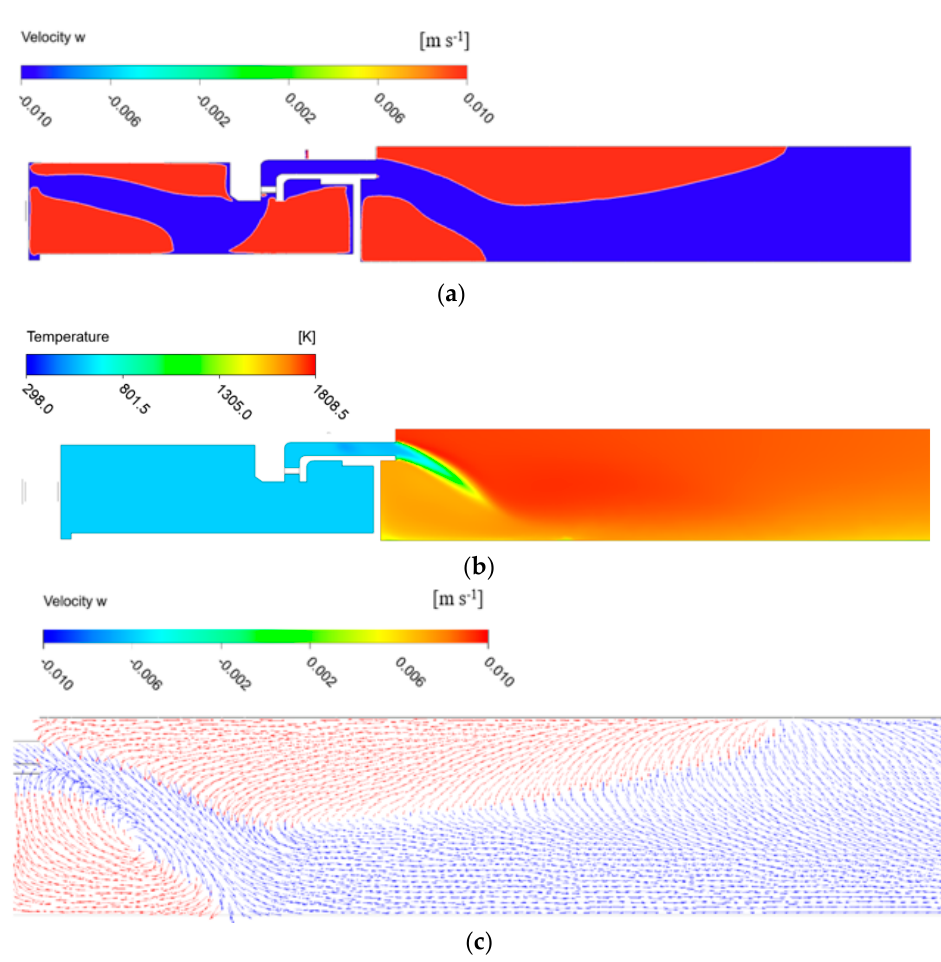
Figure 6. Velocity contour ( a ), Temperature profile ( b ), and Velocity profile ( c ).